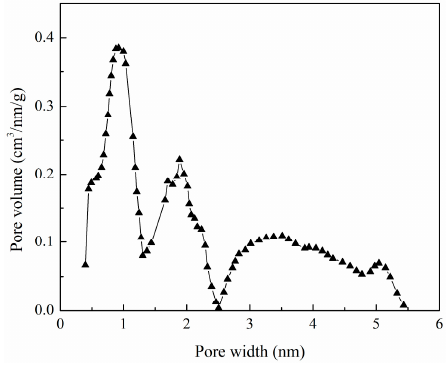
Figure 1. Pore size distribution of XSBLAC. Table 2. Global Surface Composition as Determined by EDX